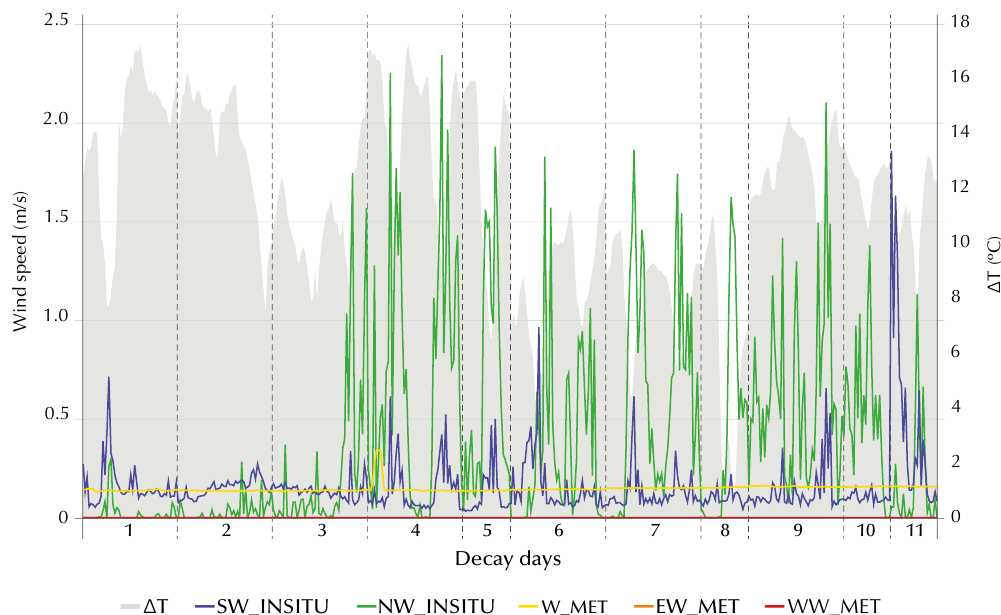
Figure 8. Wind speed and ∆ T averages of spring (P_3_C) at ten-minute time-step. As in the second period, there is a rise and fall pattern, which is more evident for W_MET and WW_MET. In this figure, it is difficult to see the EW_MET because its curve is behind the W_MET.